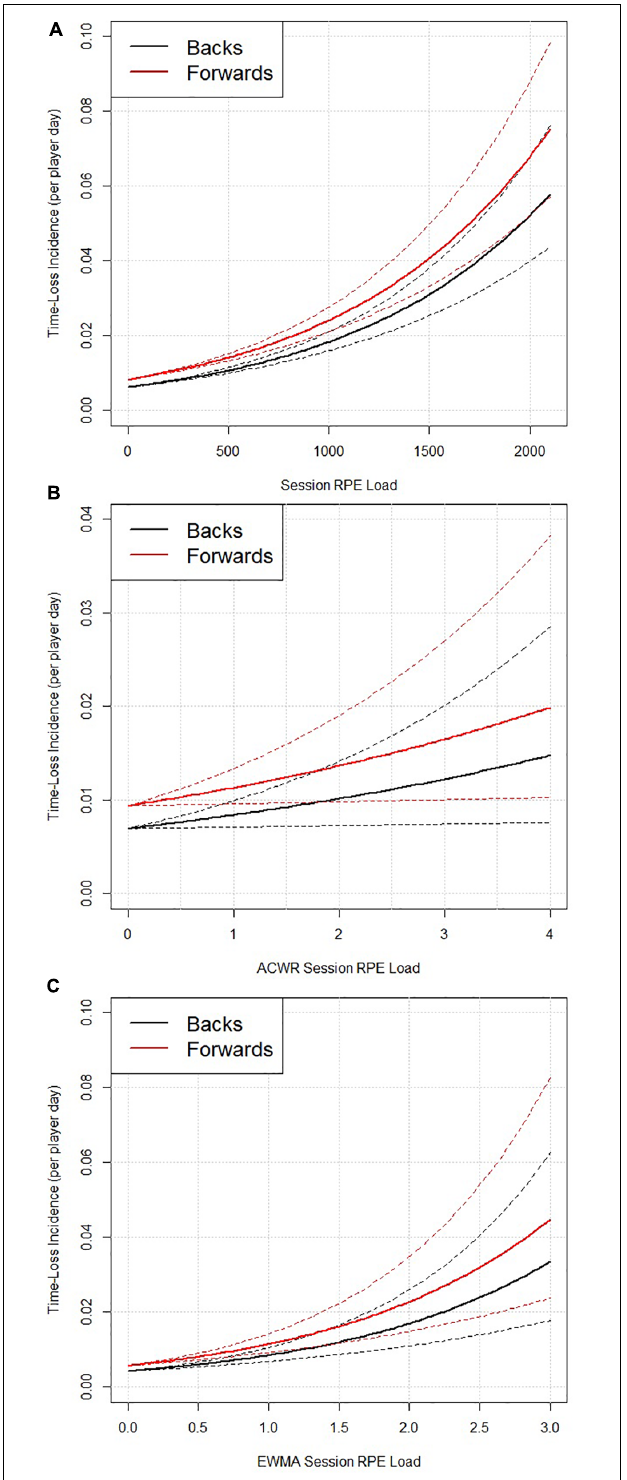
FIGURE 1 | The relationship between time-loss incidence occurrence (per player day) and absolute session RPE load ( p < 0.001) (A) , ACWR session RPE load ( p = 0.255) (B) , and EWMA session RPE load ( p = 0.001) (C) , split for backs and forwards. Data are mean ± standard error.